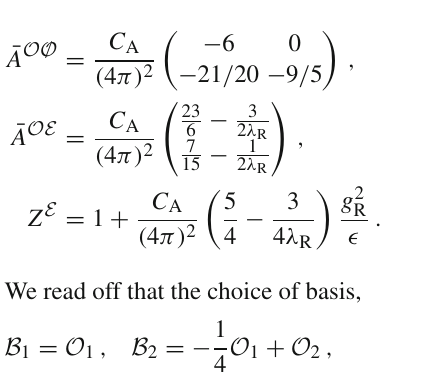
terms ( C A = N for gauge group SU(N))